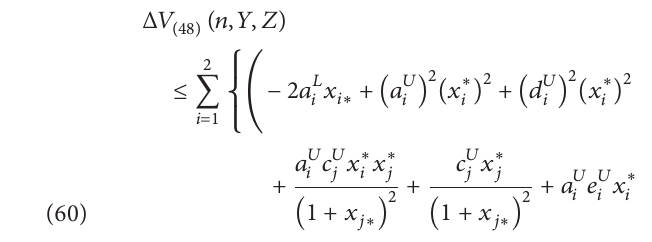
(0) = 0.023 and 𝑥 2